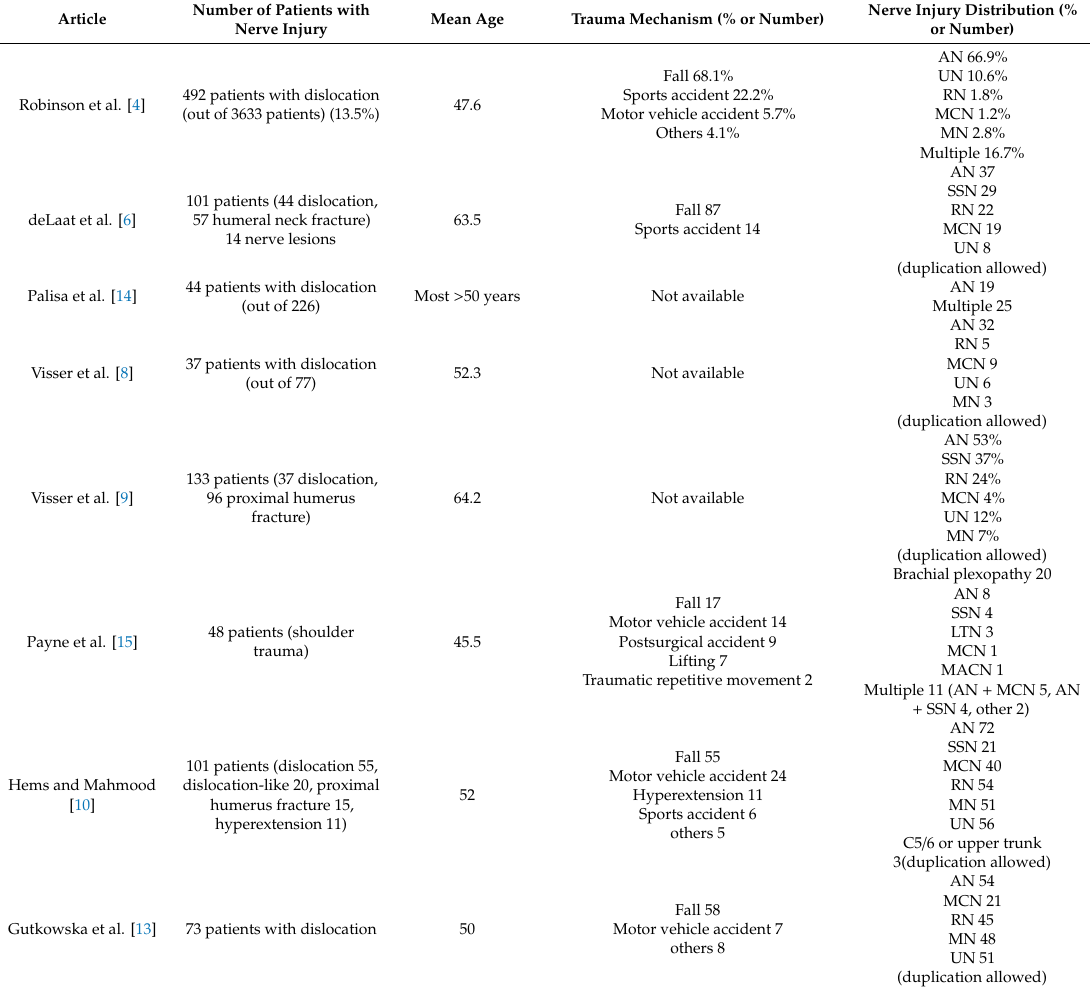
Table 6. Articles Reporting Peripheral Nerve Injuries Following Shoulder